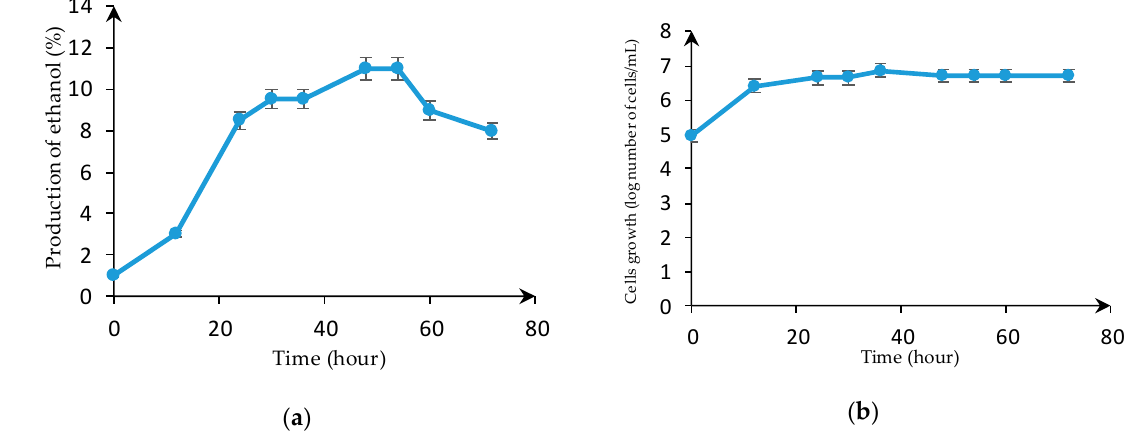
Figure 5. S. cerevisiae sahand 101 culture in a 5 L bioreactor containing the optimized medium. ( a ) Production of bioethanol; ( b ) yeast cell growth.